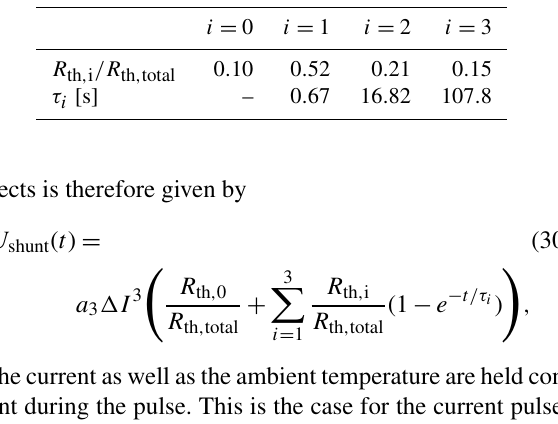
Figure 8. Normalized change in shunt voltage due to self-heating after a current step. Table 4. Extracted parameters for the dynamic thermal model due to self-heating by nonlinear least-square curve fitting.